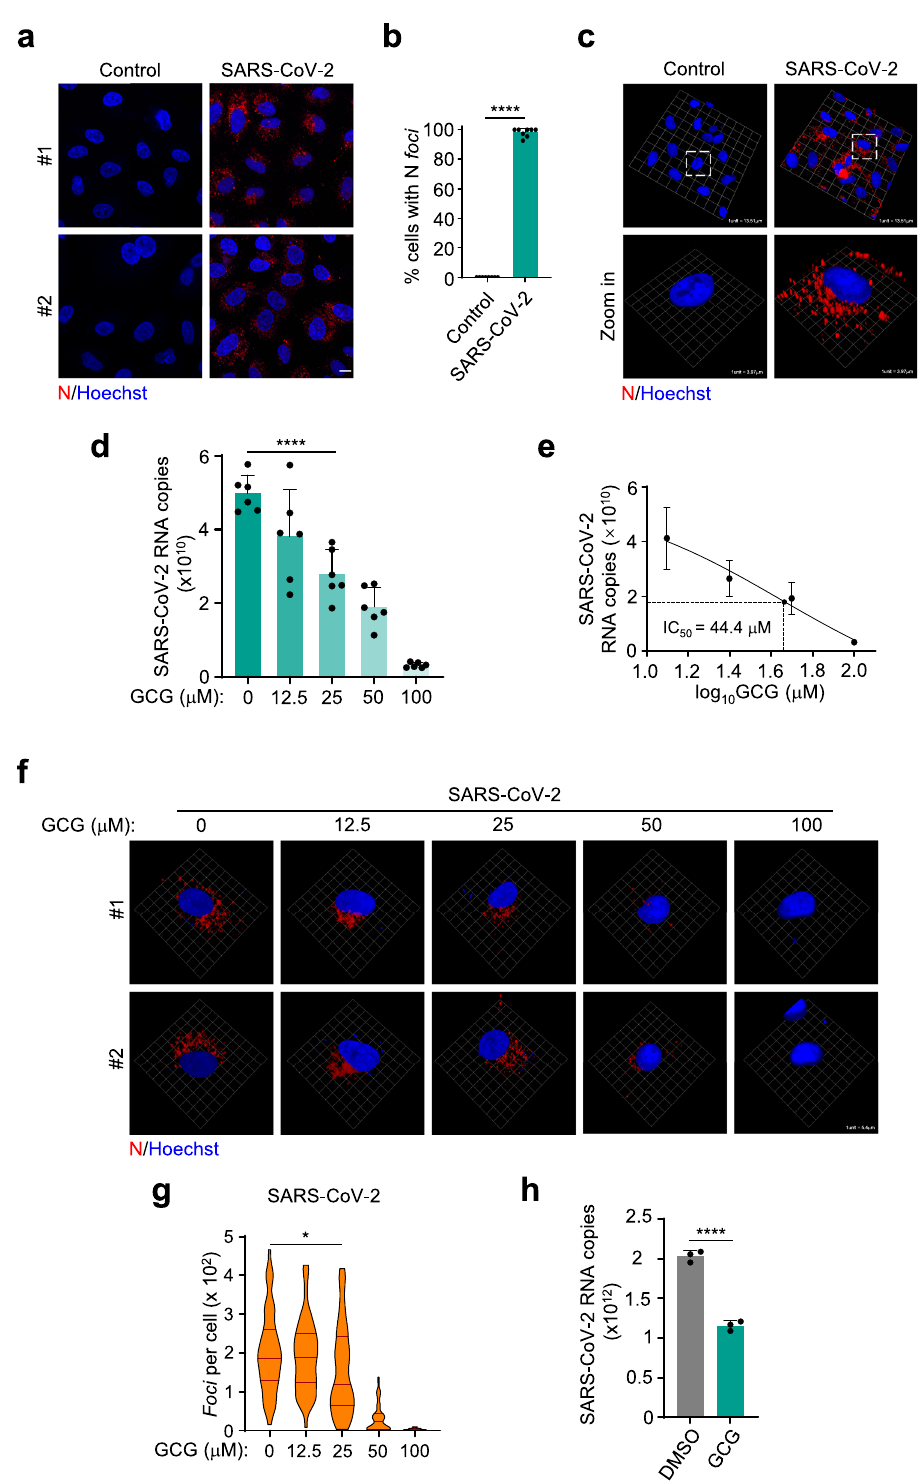
Fig. 7 GCG suppresses SARS-CoV-2 replication. a , b Immuno fl uorescence analysis of N protein in A549-hACE2-Flag cells infected with SARS-CoV-2 for 24 h ( a ). The percentage of cells with N protein foci was quanti fi ed, n = 8 biologically independent samples, 20 randomly selected views were analyzed in each sample ( b ). Scale bar, 10 μ m. c 3D images were obtained by Zeiss LSM 880 confocal microscope and reconstituted by Volocity 6.1.1 . d , e The inhibitory effect of GCG on the replication of SARS-CoV-2, n = 6 biologically independent samples ( d ). IC 50 was calculated, n = 5 biologically independent samples ( e ). The infection was performed after 1-h pretreatment of GCG. f , g Representative immuno fl uorescent images showed the inhibitory effect of GCG on SARS-CoV-2 N protein. 3D images were obtained by Zeiss LSM 880 confocal microscope and reconstituted by Volocity 6.1.1 ( f ). Violin plots showing foci of cells ( n = 50 biologically independent cells) from each group, lines within the plots, with 25th, 50th, and 75th percentiles marked ( g ). h Cells were infected with SARS-CoV-2 for 1 h followed by 24-h GCG treatment, n = 3 biologically independent samples. Representative images were shown. SARS-CoV-2 was used at an MOI of 1. Hoechst (blue), nuclear staining ( a , c , f ). Error bars, mean with s.d. ( b , d , e , g , h ). Two-tailed unpaired Student ’ s t -test, * P < 0.05, **** P < 0.0001. Data are representative of at least three independent experiments. Source data are provided as a Source Data fi le. NATURE COMMUNICATIONS| (2021) 12:2114